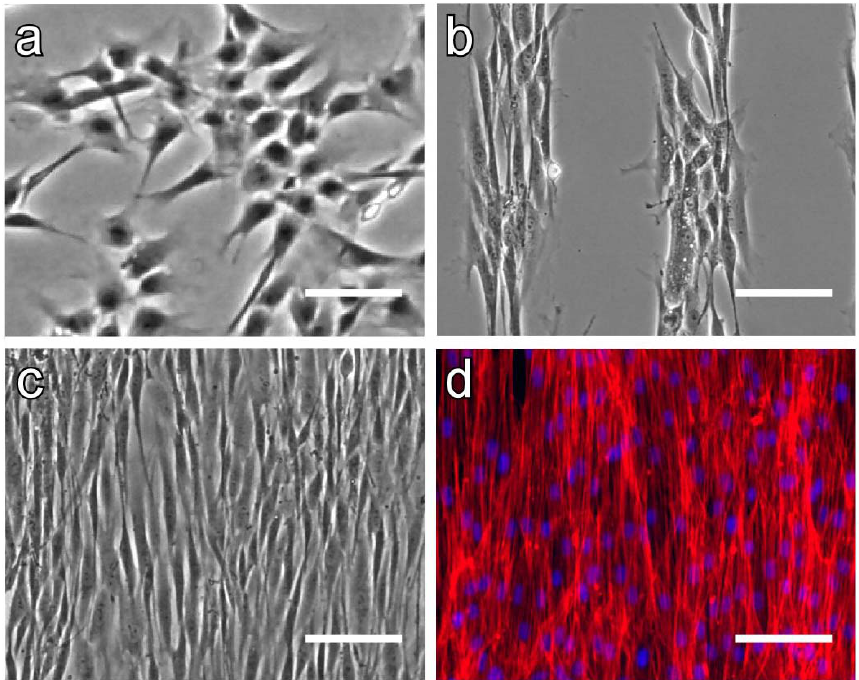
Figure 12. Phase contrast microscopic photographs of adhering normal human dermal fibroblasts (NHDFs) on ( a ) non-patterned PIPAAm brush surface and ( b ) a poly( N -isopropylacrylamide- block - N -acryloylmorpholine) (PIPAAm- b -PAcMo) patterned brush surface with 100 µm width stripe patterns after 24 h cell culture. ( c ) Phase contrast microscopic image and ( d ) fluorescence image of adhering NHDF sheet on PIPAAm- b -PAcMo patterned brush surface with 50 µm width stripe patterns after 5-day cell culture. Actin (red) and nuclei (blue) in aligned NHDFs on a patterned surface (d) are stained with AlexaFluor568-phalloidin (red) and Hoechst 33258 (blue), respectively. Scale bar: 100